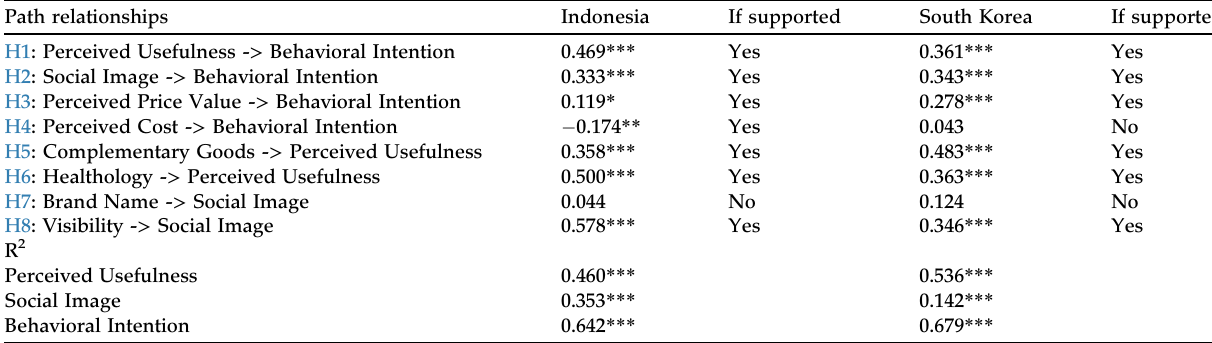
Table 7. Result of the country-speci fi c structural model. Path relationships